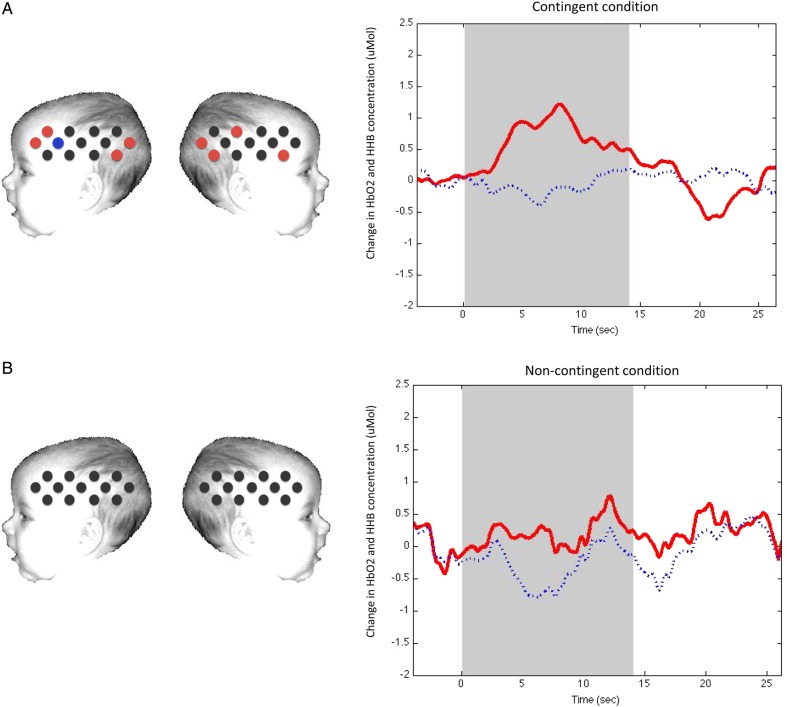
A schematic view of the fNIRS arrays with channels showing a significant increase in HbO2 during (a) the contingent condition compared with baseline and (b) the non-contingent condition compared with baseline (time window 10–18 s) in Experiment 1. Channels colored in red show a significant HbO2 increase in activation by standard analysis (not FDR corrected). Time courses on the right of the figure show HbO2 activation (in red) and HHb activation (in blue), in channel 26 during the contingent (top panel) and non-contingent (lower panel) conditions. Note that standard analysis is shown. No channels show a significantly greater hemodynamic change in the non-contingent condition compared with the contingent condition. Note that the schematic is used for illustrative purposes only.